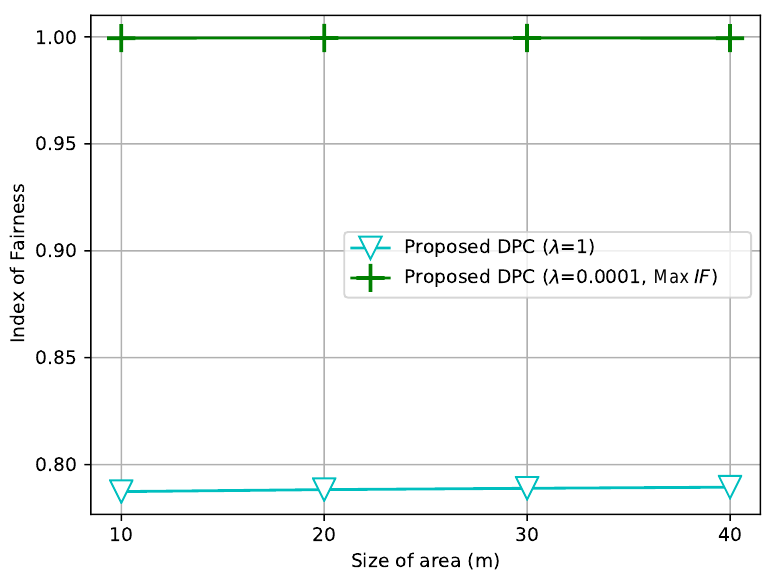
Figure 8. Index of fairness of the proposed DPC scheme with λ = 1 and 0.0001 in Rayleigh fading channels.